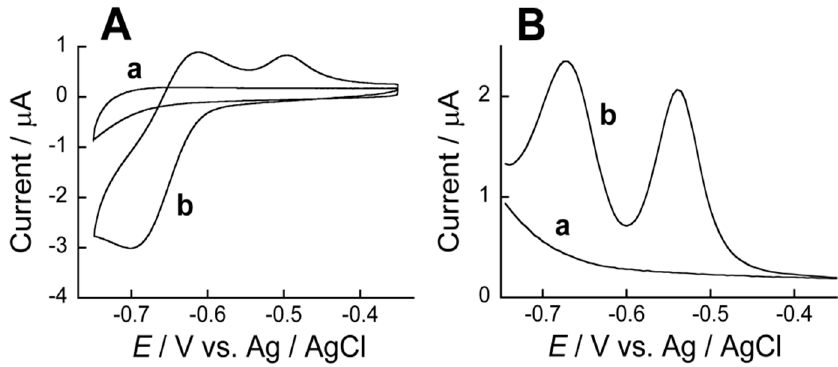
Figure 5. A typical CVs ( A ) and DPVs ( B ) of Au electrodes coated with (PBA-PEI/CMC) 10 PBA-PEI film with (b) and without (a) ARS. CVs were recorded at pH 9.0.